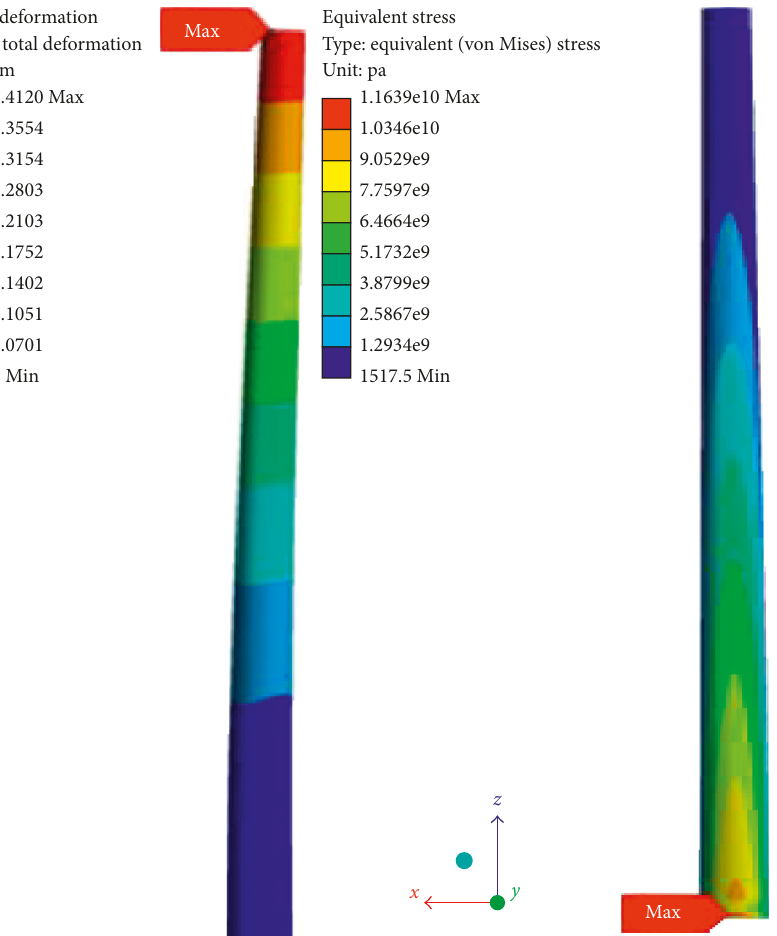
Figure 9: The distribution of the von Mises stress